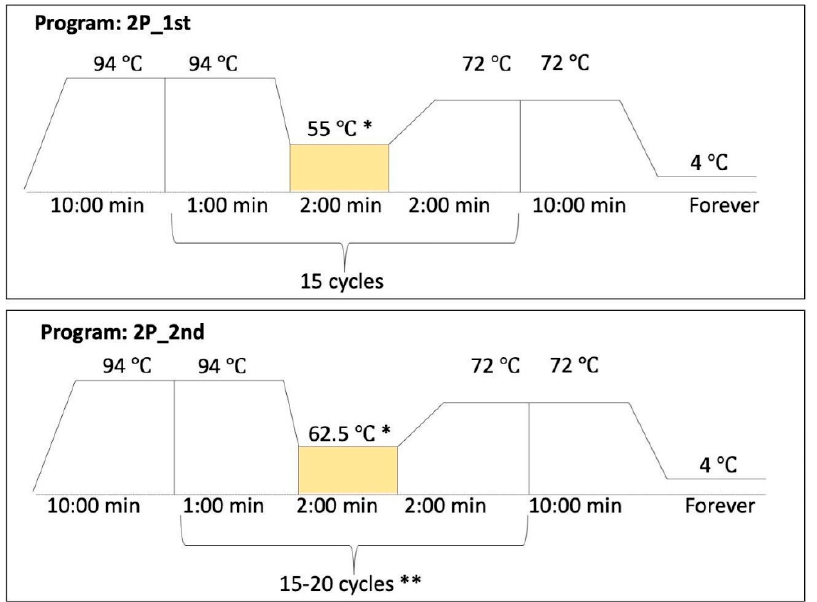
Figure 3. Thermocycler programs for two-step PCR (2P) workflow. * Decrease by 0.3 degree Celsius every cycle; ** We recommend using 15 cycles. However, if PCR yielded low DNA concentrations, the number of cycles can be increased up to 20.